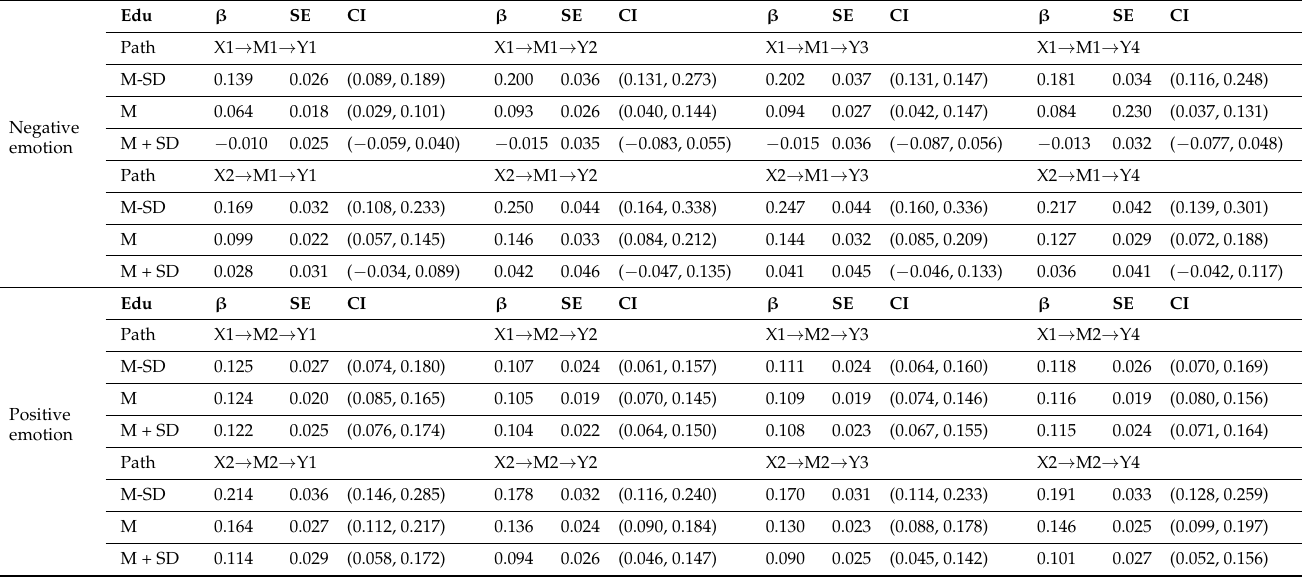
Table A3. The mediating effect of emotion at different levels of